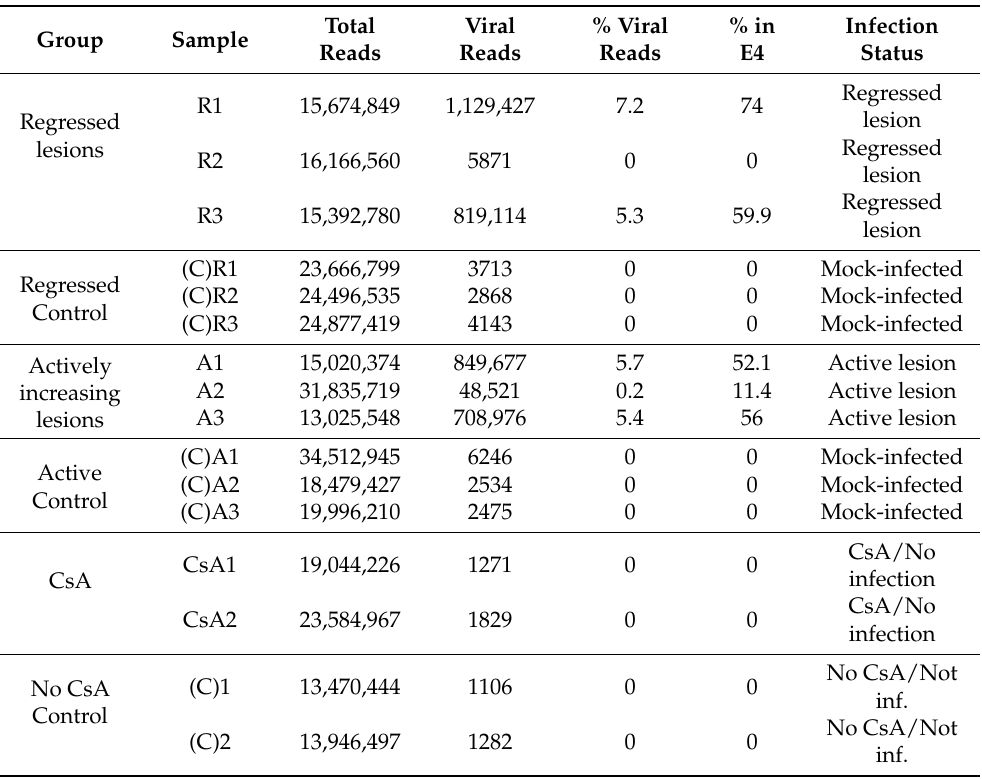
Table 2. Total viral reads and percent viral reads within E4 region in active, regressed and control tissues. Total Group Sample Reads